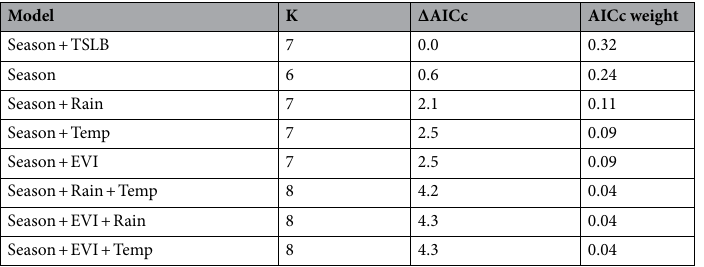
Table 3. Top models for the same seasonal comparisons between consecutive years (only models contributing ≥0.04 of the AICc weight are shown). For all models, elephant family group identity was included as a random effect. Temp temperature, BIS percentage of UD burned within season, BLS percentage of UD burned in last fire before season, TSLB time since last burn in UD before season.